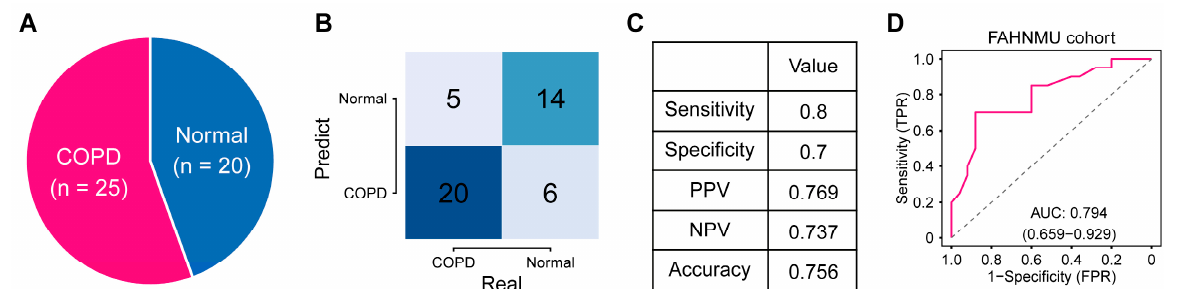
Figure 5. Independent validation of the miRNA pair-based diagnostic model in an external cohort. ( A ) A summary plot of the samples used in the FAHNMU cohort; ( B ) Confusion matrix comparing proportions of predicted COPD and healthy controls in different groups stratified by the miRNA pair-based model; ( C ) Performance of the diagnostic model on the external dataset. PPV, positive predictive value; NPV, negative predictive value; ( D ) ROC curves measuring the predictive performance of the model in the FAHNMU cohort.